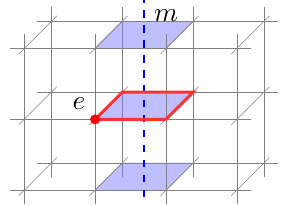
Figure 22. The double braiding of an e -particle and an m -string is − 1 .